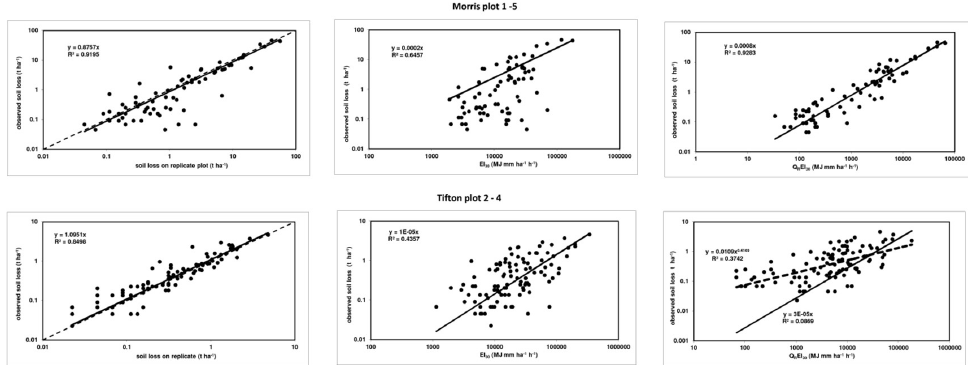
Figure 16. Relationships between observed event soil loss and loss from a replicate; EI 30 and Q R EI 30 values for storms on plots at Morris, MN and Tifton, GA (source Kinnell [63]). Table 6. NSE(ln) values when USLE, USLE-M, and replicate models were applied to bare fallow plots in the USLE database (source: Kinnell [63]).